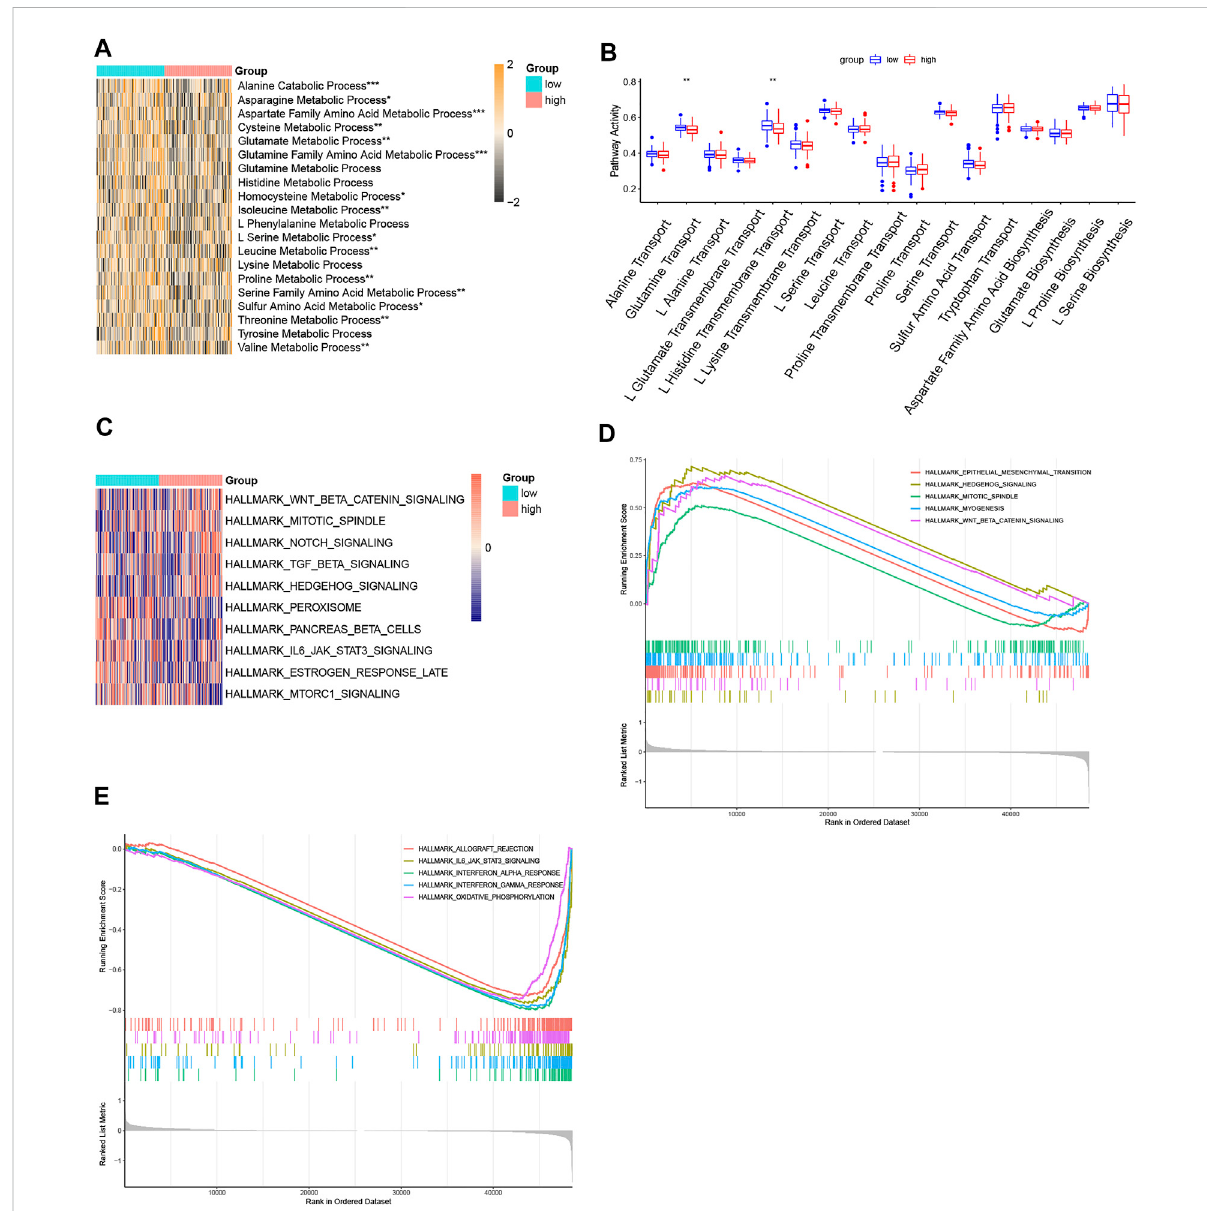
FIGURE 8 Function enrichment analyses. (A) Heatmap of ssGSEA of the amino acid metabolism pathways. (B) Boxplot of ssGSEA of the amino acid synthetic and transport pathways. (C) Heatmap of the top fi ve positive or negative related with risk score. (D) GSEA plot of the top fi ve activated pathways with the highest enrichment scores. (E) GSEA plot of the top fi ve suppressed pathways with the lowest enrichment scores. ( p < 0.05 *, p < 0.01 **, p < 0.001 ***, and p < 0.0001